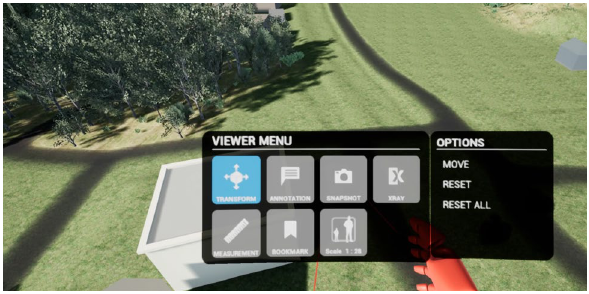
Figure 10 . Viewer menu for selection of functionalities